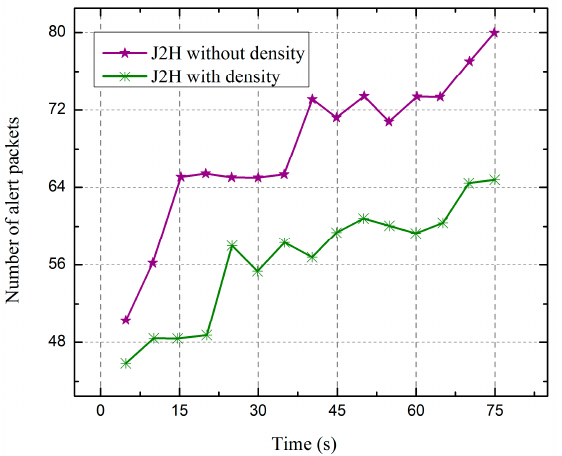
Figure 9. Analysis of the number of alert packets transmitted in J2H approach when time changes with low density and high density of vehicles.